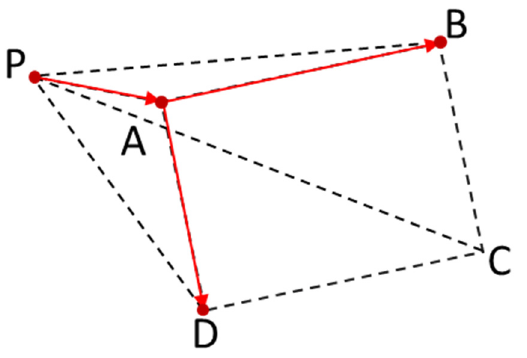
Figure A2. Vector definition of a single camera capture volume used to determine FoV intersections with multiple cameras.